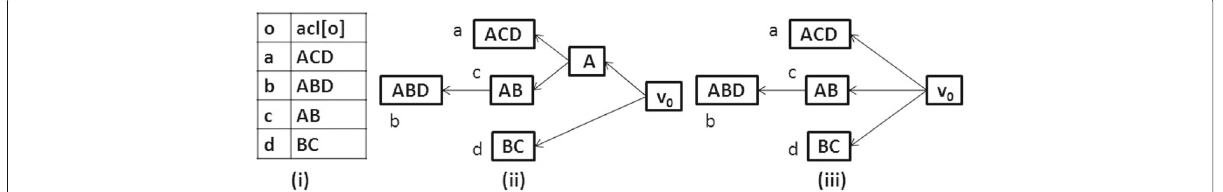
For a given set of ACLs, more than one user trees can exist. An example with four users U = { A , B , C , D } and four resources R = { a , b , c , d } is shown in Fig. 7. Figure 7i represents example ACLs, and Figure (ii) represents one possible user tree corresponding to the given ACLs. Each node in the user tree represents a user grouping, i.e.,